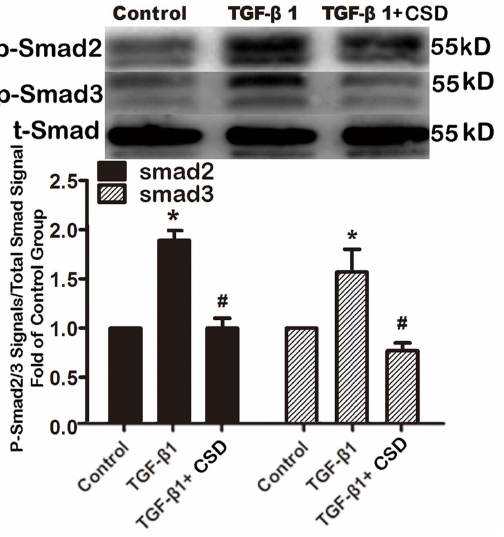
Figure 9. The CSD peptide inhibited TGF- b 1-induced activation of Smad 2/3 in HAFs. HAFs were pretreated with the CSD peptide at a concentration of 5 m M or the Scr peptide (5 m M) for 30 min, and subsequently incubated with or without 100 ng/ml TGF- b 1 for 48 h. Note that the CSD peptide abrogated the TGF- b 1-induced upregulation of phosphorylated Smad 2 and 3. HAFs, human atrial fibroblasts. The CSD peptide, peptides derived from the scaffolding domain of Cav-1. Scr peptide, scrambled peptide. p-Smad2,phosphorylated Smad 2. p-Smad3,phosphorylated Smad 3. t-Smad, the total Smad 2/3. *P , 0.05 vs. Control; # P , 0.05 vs. TGF- b 1; n=4 per group; measure- ment in triplicate for each single experiment.